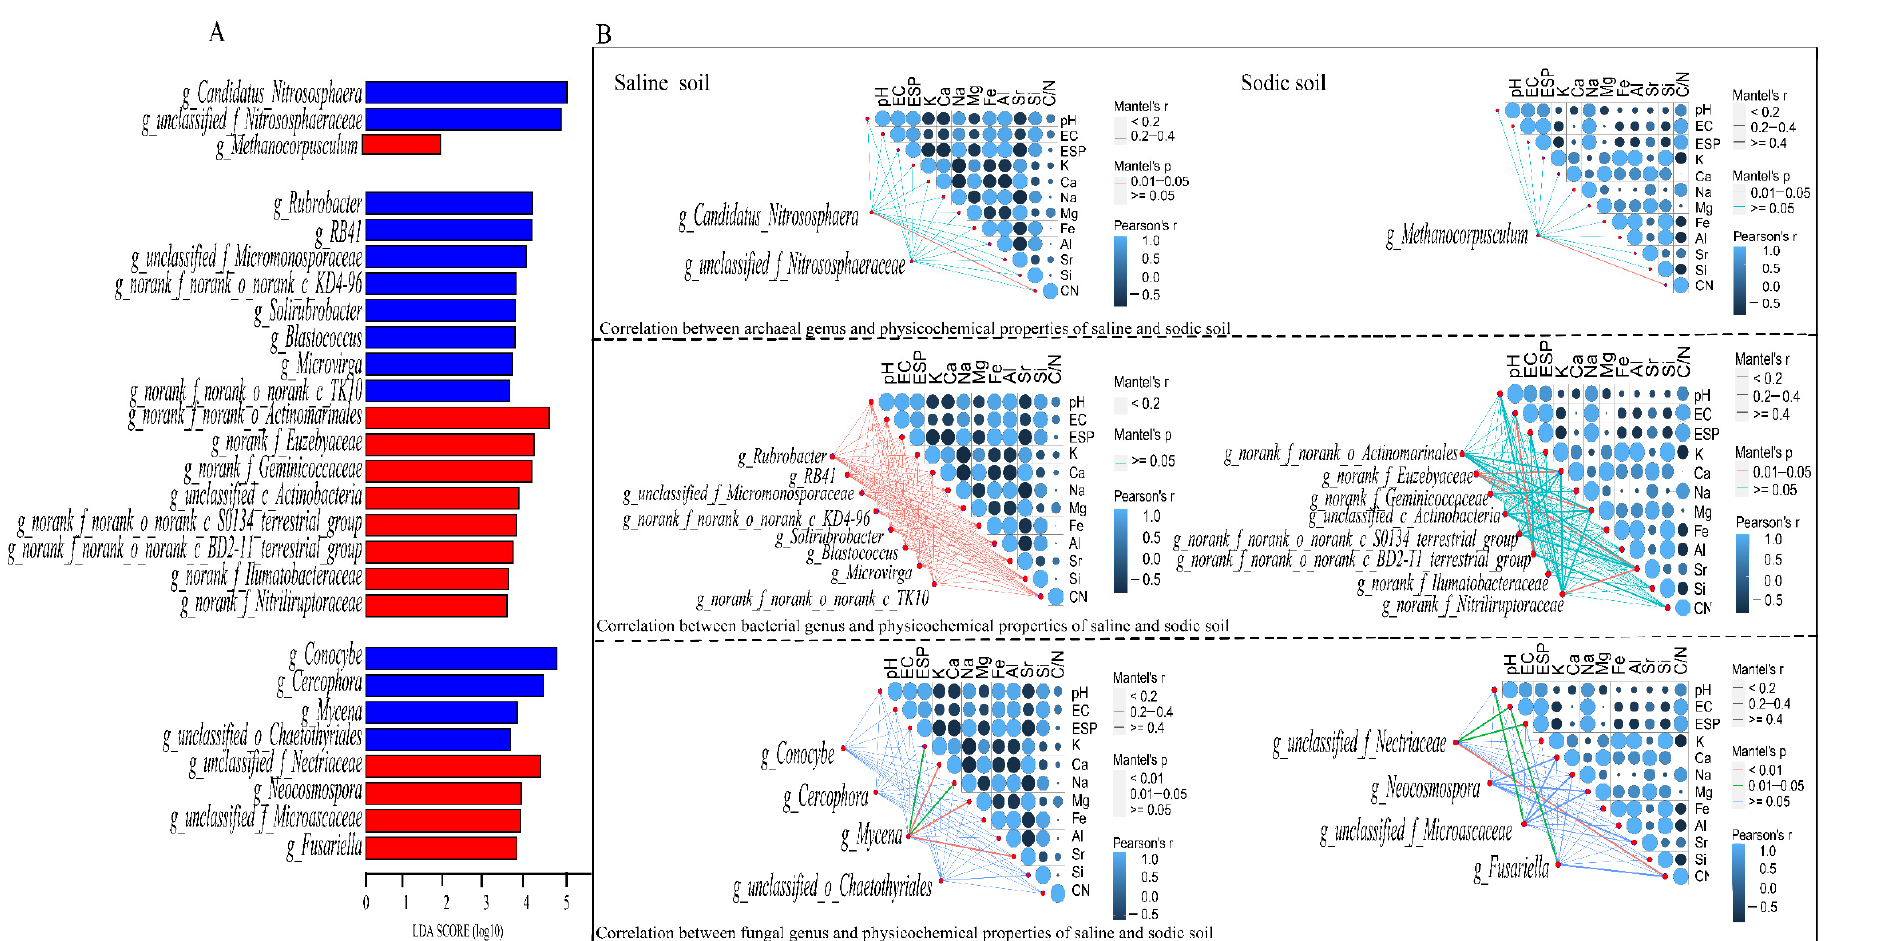
Figure 6. ( A ). Dominant microorganisms at genus in saline soil (blue frame) and sodic soil (red frame) based on LEfSe identities (LDA scores greater than 2.0). ( B ). Relative abundance of the dominant genus related to soil environmental factor by partial Mantel test; edge width corresponds to the Mantel’s r statistic for the corresponding distance correlations, and the edge color denotes the statistical significance based on 9999 permutations.